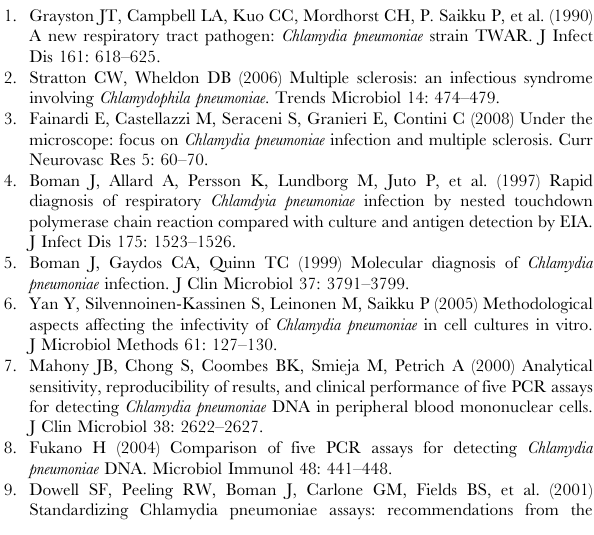
Assay Plasmid numbers per reaction (copies/ml